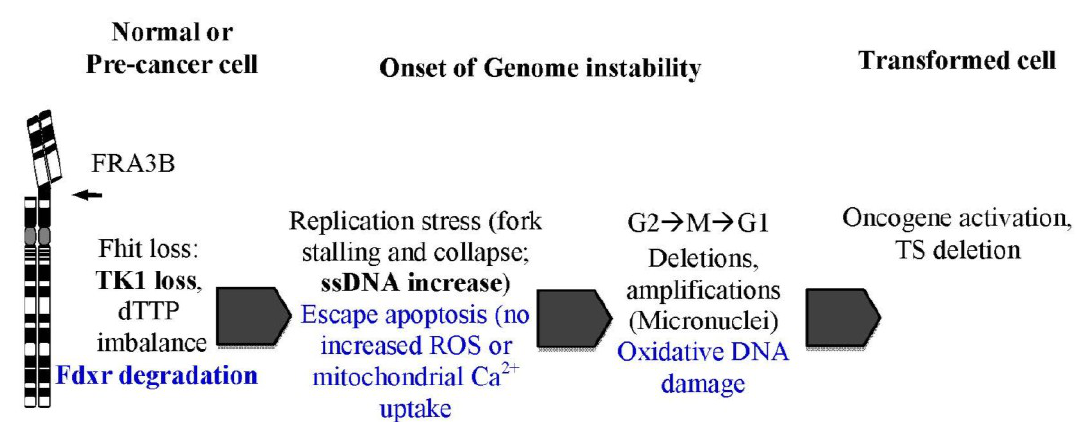
Figure 4. Model for FHIT loss-induced genome instability and neoplasia formation. Deletions in FHIT alleles occur due to FRA3B fragility. FHIT loss causes TK1 loss